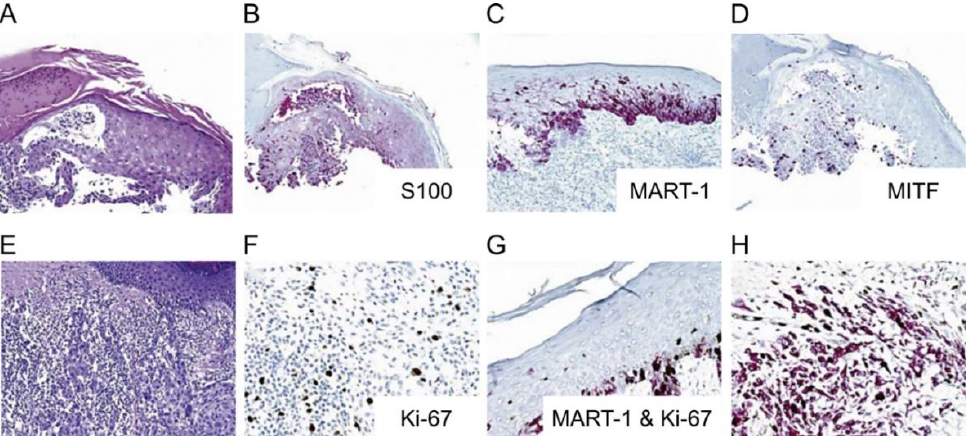
Figure 10. Melanocytic Markers: (Reproduced from “Diagnostic Immunohistochemistry in Cutaneous Neoplasia” by Compton et al., published by Karger Publishers under the Creative Commons CC-BY-NC 3.0 License [132] ( A ) Melanoma in situ, ( B ) S100 stained, ( C ) MART-1 (Melanoma antigen recognized by T cells-Cloned gene) stained, ( D ) MITF (Micropthalmia-associated transcription factor) stained, ( E , F ) Ki-67 stain of a melanoma with a tumor infiltrating lymphocytic response ( G , H ) Ki-67 and MART-1 stain on a melanoma that shows melanocytic lineage cellular proliferation [132].